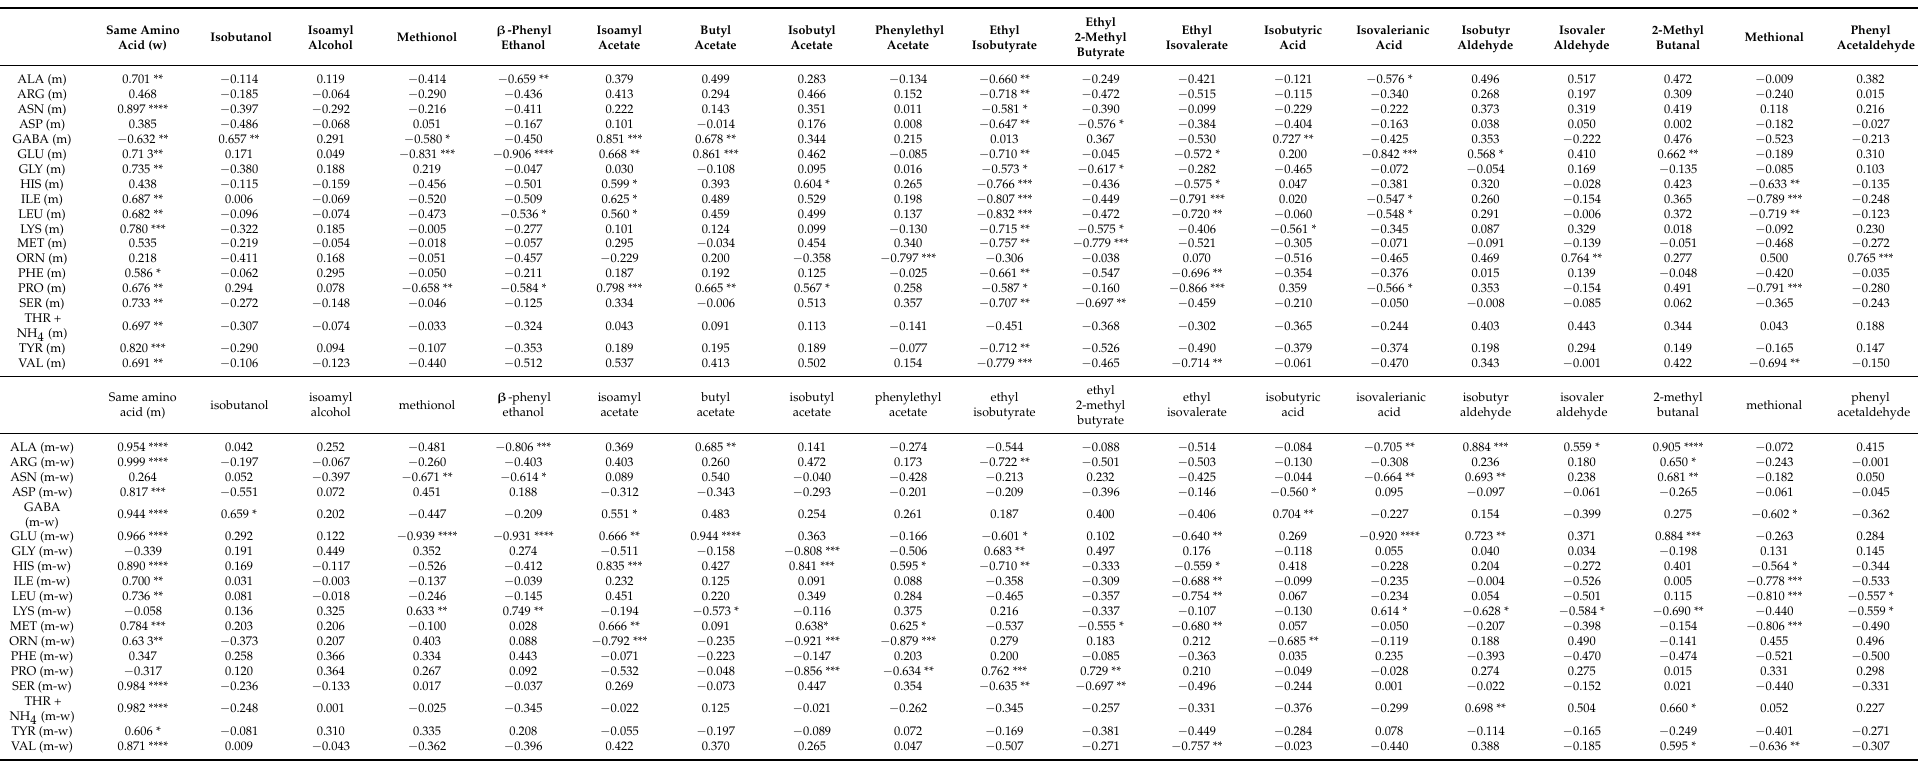
Table 2. Table of correlations between the amino acids in mistelle (m) and the difference between the initial amino acid concentration in mistelle and final levels in wine (m-w) with fermentative aroma compounds in wine (w). Data are given as Pearson correlation coefficient (R). Significance ( p -value): **** p < 0.001; *** 0.001 < p <